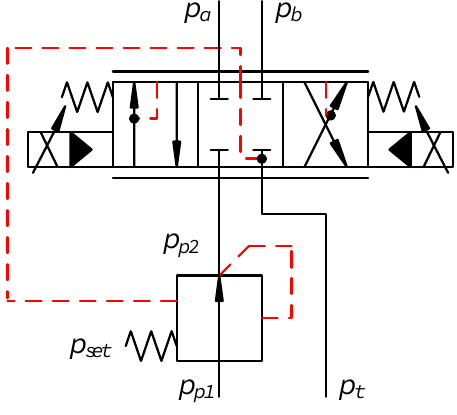
Figure 6. Hydraulic pressure-compensated directional